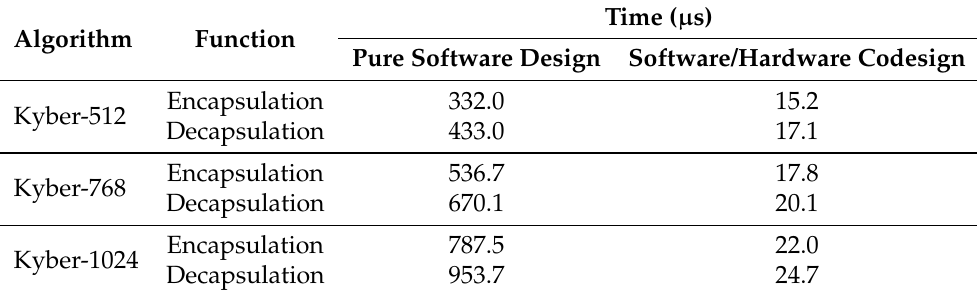
Table 4. Existing pure software design and software/hardware codesign results of Kyber [36].